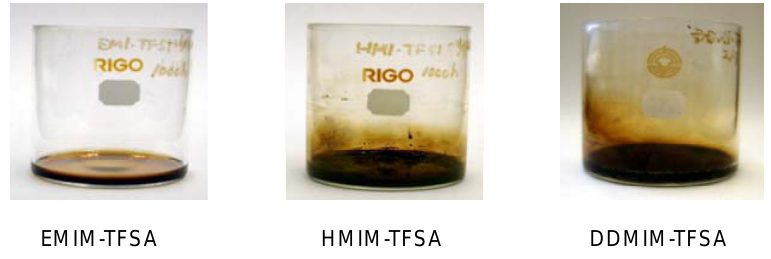
Figure 9. Photograph of samples kept at 200 °C for 1,000 h.